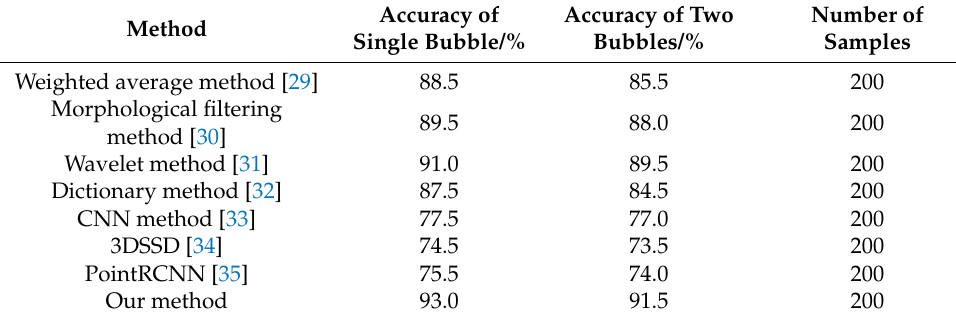
Table 1. Accuracy comparison of different tire defect